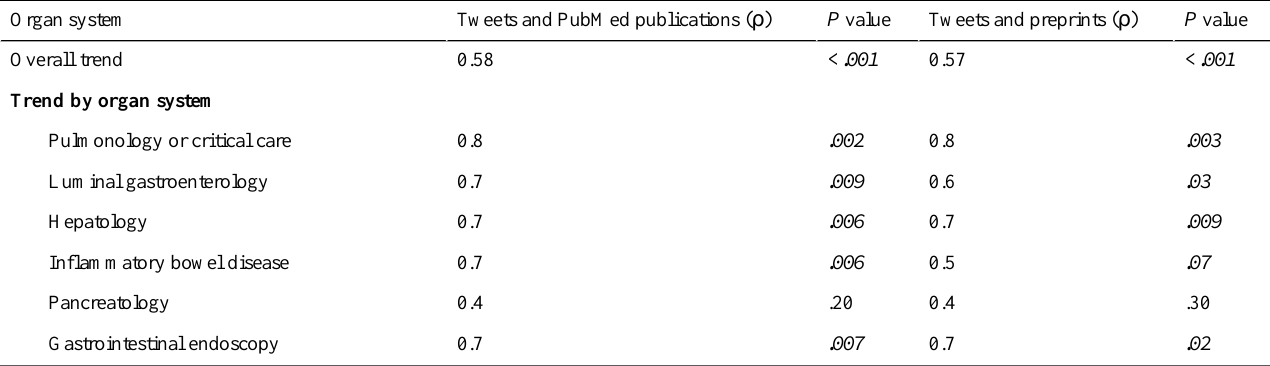
Table 2. Correlation between Twitter activity (tweets) and PubMed publications and between Twitter activity (tweets) and preprints by organ system. Italicized values indicate statistical significance.